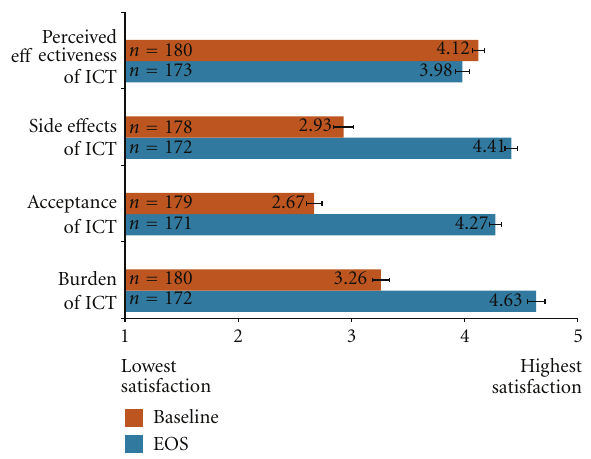
Figure 3: Mean SICT domain scores at baseline and EOS for overall β -Thalassemia population.